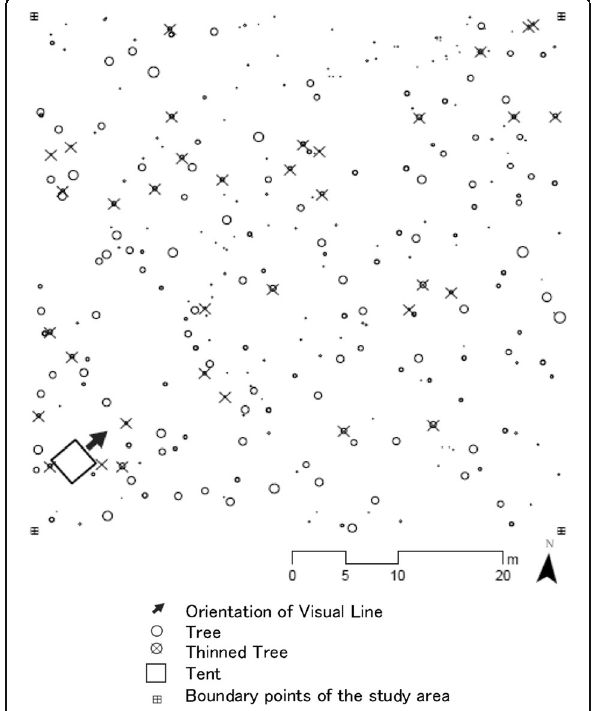
Fig. 2 Situation of the experimental